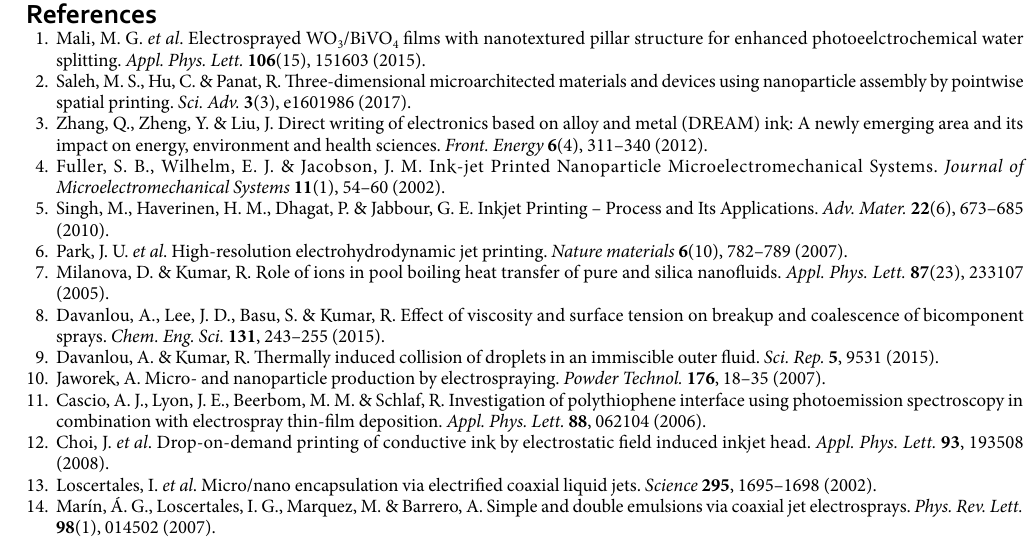
set of experiments (i.e., 0 ≤ φ 0 ≤ 5000 V) was repeated at least three times for each semiconductor nanosuspen- sion including the SDS solution. Using the video data, the volume of the droplets was calculated by image processing. Since the shape of the droplets was not perfectly spherical and varied with time during their free fall, a Riemann sum, i.e., the sum of 2 , under the assumption that the falling droplet slices of 1 pixel each, was used to compute the volume, V = π ∑ = r in i 0 is axisymmetric at all instances. Here, r i is the radius of the i th slice. The radius of each droplet was then deter- mined as r = π V 3 /4 3 . Finally, the average radius of the droplet was calculated as the mean value and its standard deviation was used to compute the uncertainty in the measurements. Also the frequency at which the liquid meniscus oscillates at the tip of the capillary tube was determined using the video image that recorded the growth of the meniscus apex as a function of time as shown in Fig. 8. The Fig. 8a represents the periodic stretching and contraction of the apex of the conical meniscus in the microdripping mode with the apex stretching to a fixed length at the time interval of approximately 3.2 ms. Figure 8b shows the defor- mation of the meniscus with the apex moving vertically at a fairly high speed of nearly 0.6 m/s, indicating that microdroplets can be dispensed at a high rate to deliver nanoparticles for high speed manufacturing.